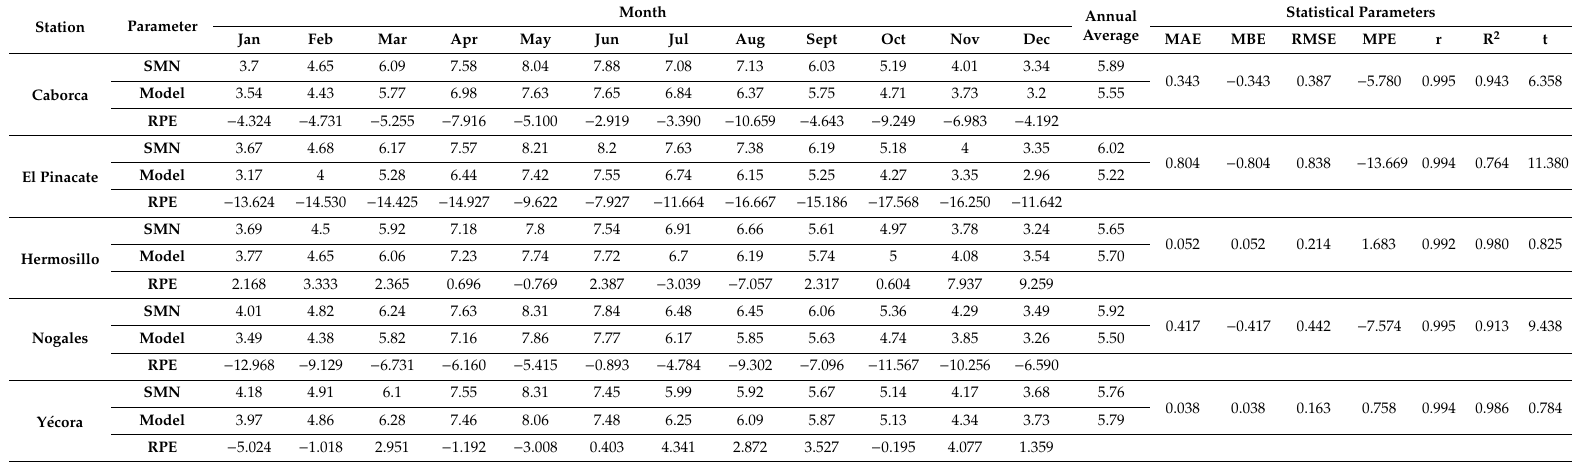
Table 5. Comparison between the SMN and the